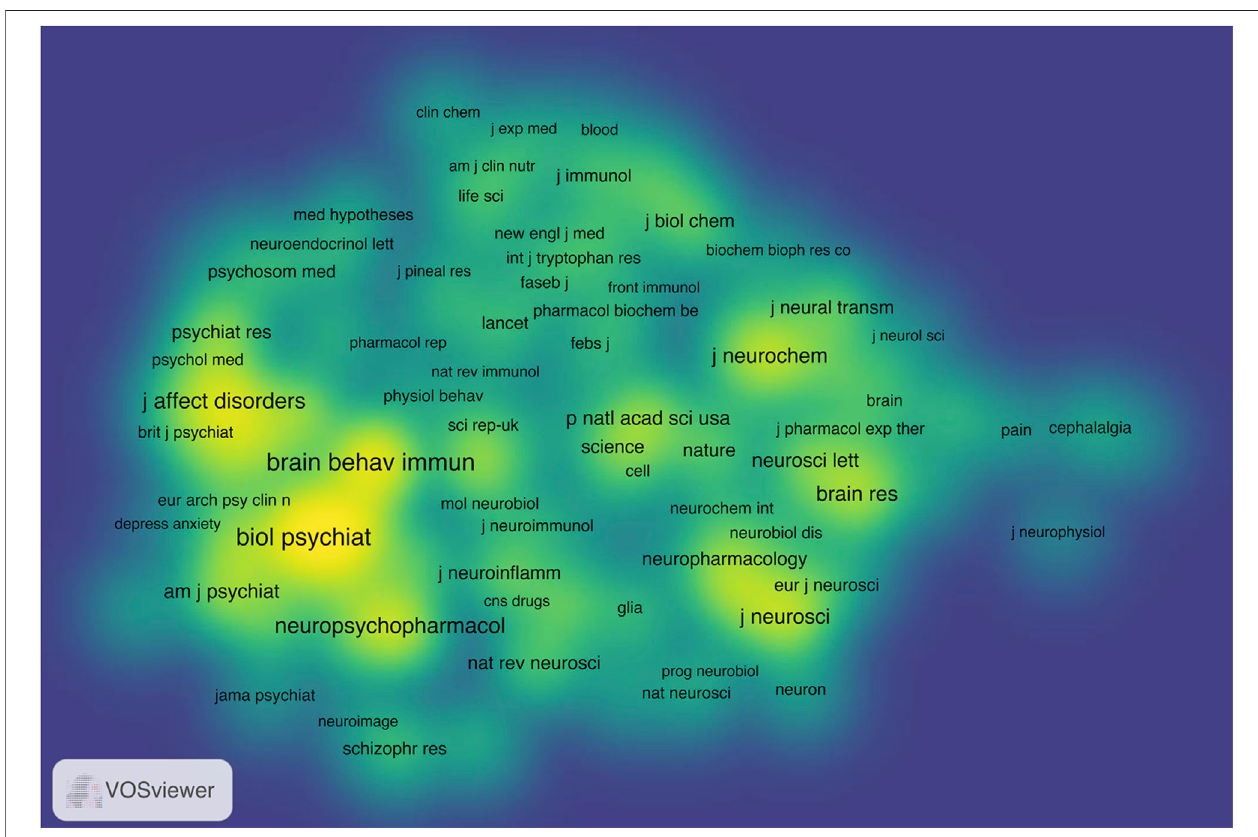
FIGURE 8 | Item density visualization of the journal co-citation analysis. The larger the number of the neighboring items and the higher the weights of the items in a point, the closer the color of the point is to yellow in the visualization.